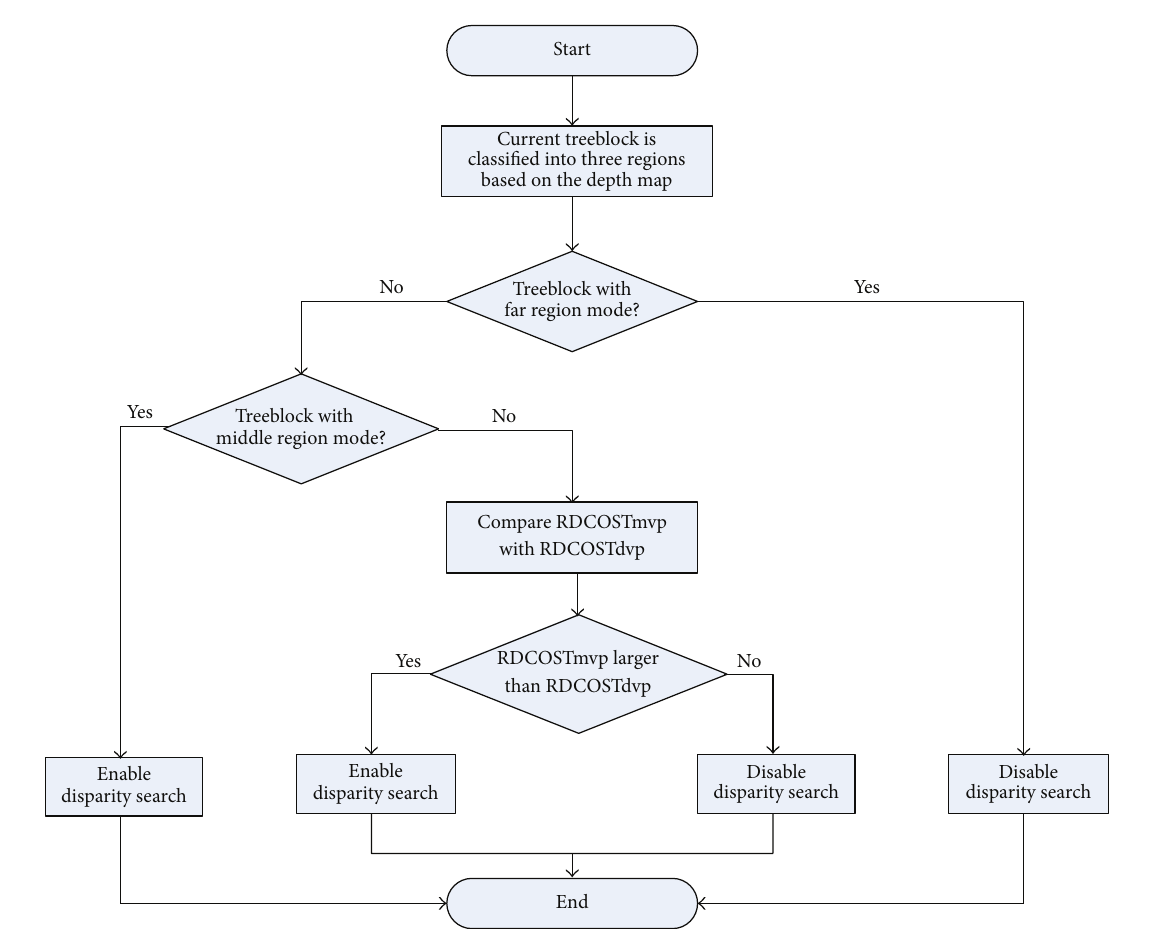
Figure 3: Flowchart of the proposed selective disparity estimation